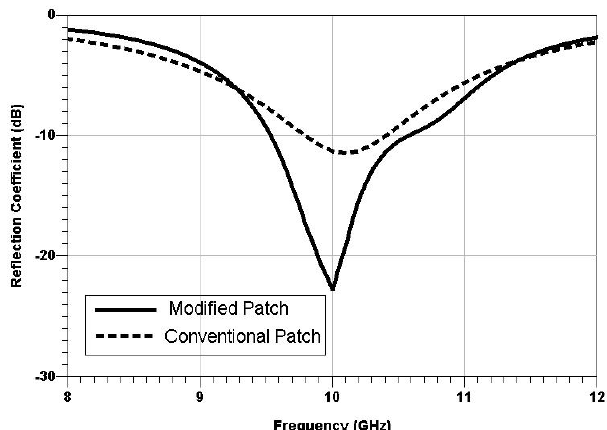
Figure 7: The simulated reflection coefficient of the modified slotted patch RAM for co polarization case.